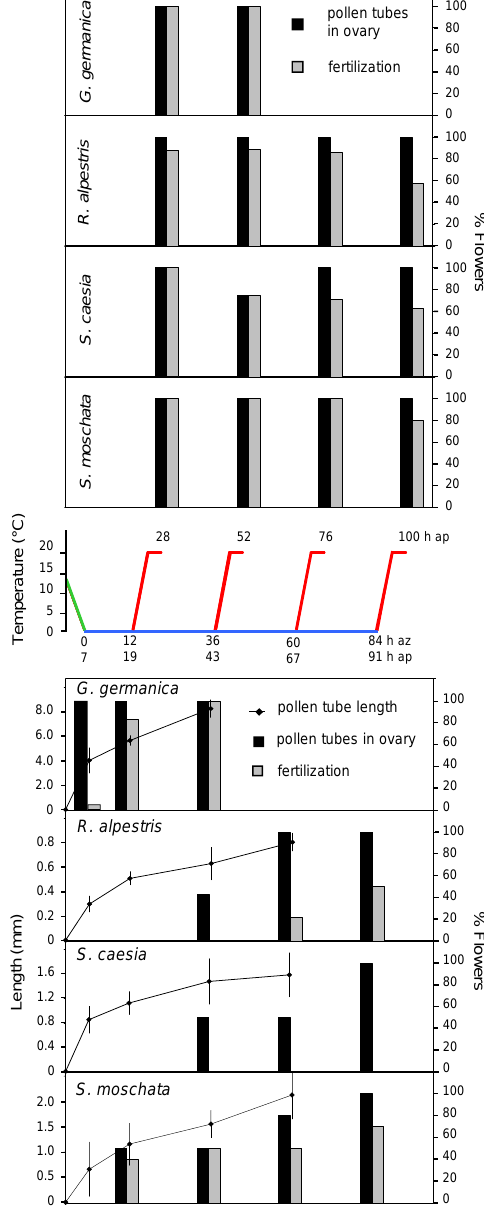
Figure 1. Performance of alpine species during the simulation of a cold snap in the laboratory. Middle graph: temperature course during the cooling-down phase (green line), the 0 °C-phase (blue line) and the warm-up phase (red line); numbers of the x-axis indicate the hours after pollination (ap) and the exposure times at zero (az). Lower graphs: mean lengths of pollen tubes (±SD) and percentages of investigated flowers with pollen tubes in the ovary and fertilized ovules, respectively, after the cooling-down phase (7 h ap) and after different exposure times at zero (12, 36, 60, 84 h az). Upper graphs: percentages of investigated flowers with pollen tubes in the ovary and fertilized ovules after different exposure times at time zero and the respective warm-up phase; S. moschata which occurs from the alpine to the nival zone was assigned to the alpine species group, as the investigated individuals originated from an alpine